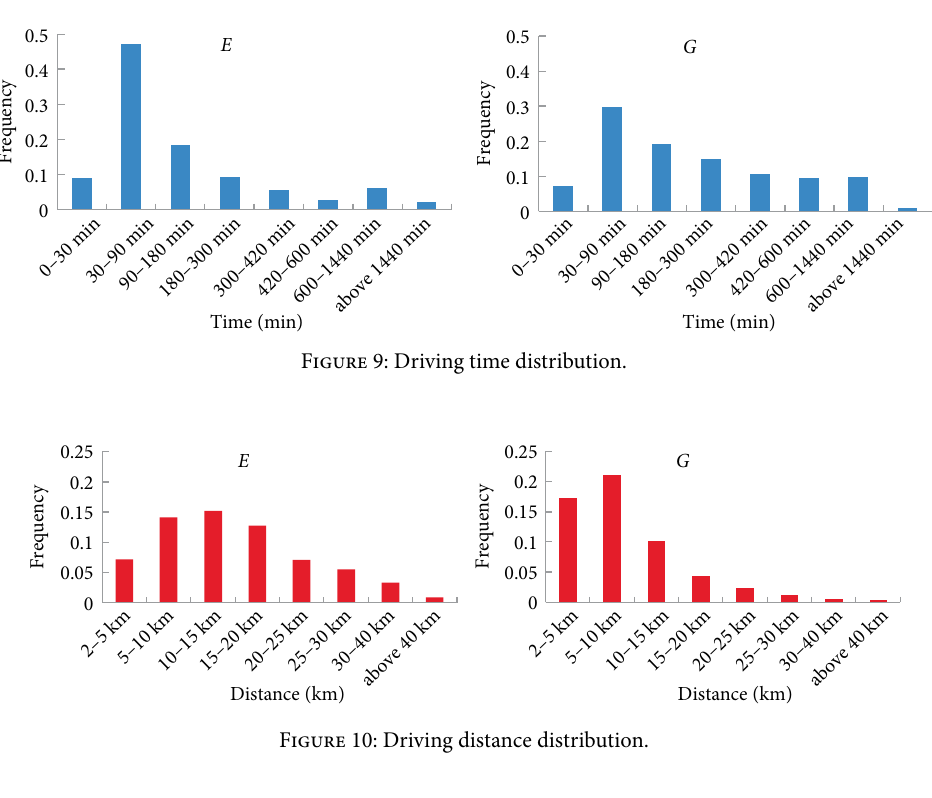
Figure 10: Driving distance distribution.